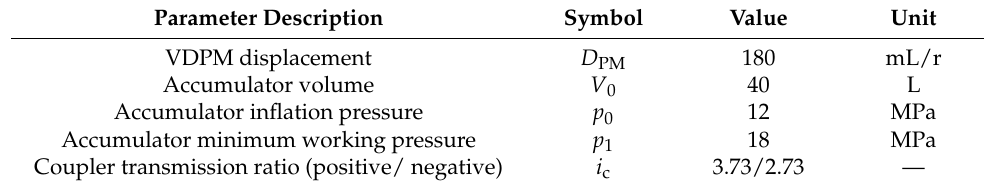
Figure 24. The test site and PHHL. Table 7. The parameters of ERS in the PHHL